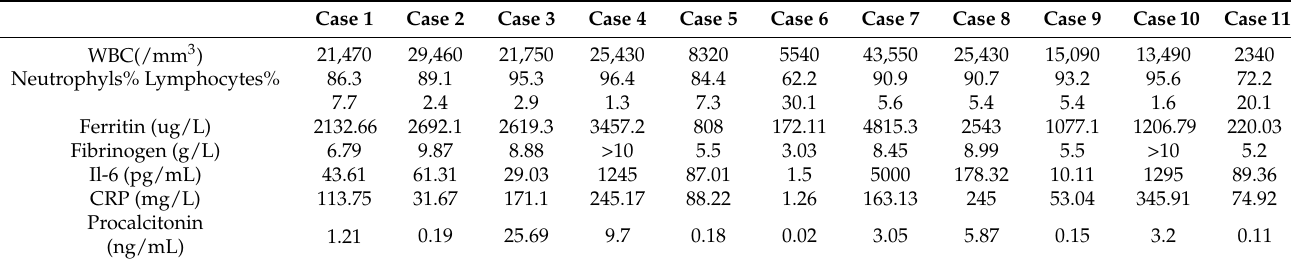
Table 2. Laboratory data of the